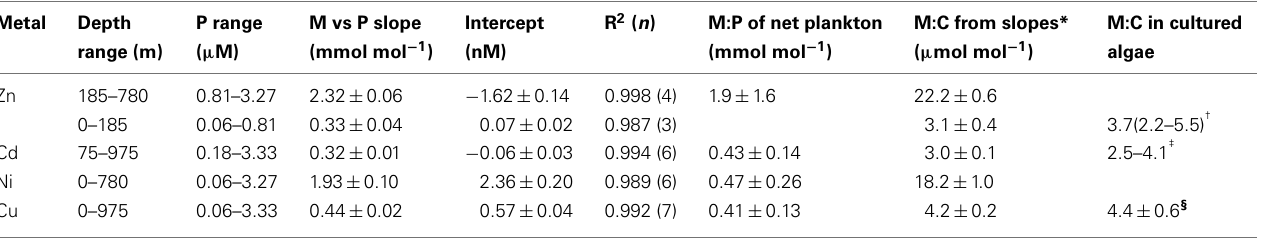
Table 2 | Comparison of slopes of nutrient metal to phosphate plots for station H-77 (Bruland, 1980) in the northeast Pacific with metal:P ratios in net plankton (Martin et al., 1976) and metal:C ratios in cultured marine algae.